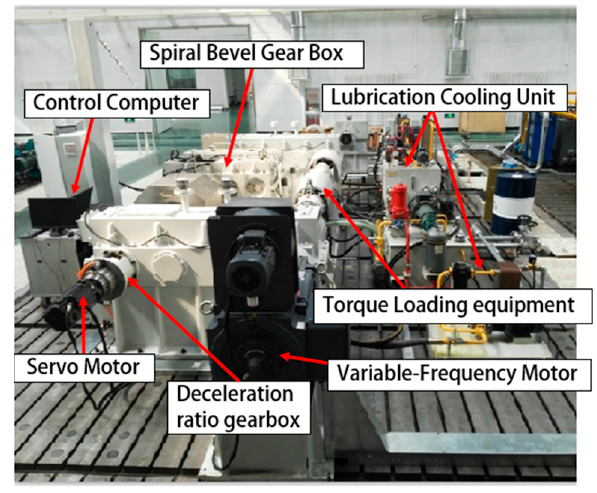
Figure 15. Composition of test bench.